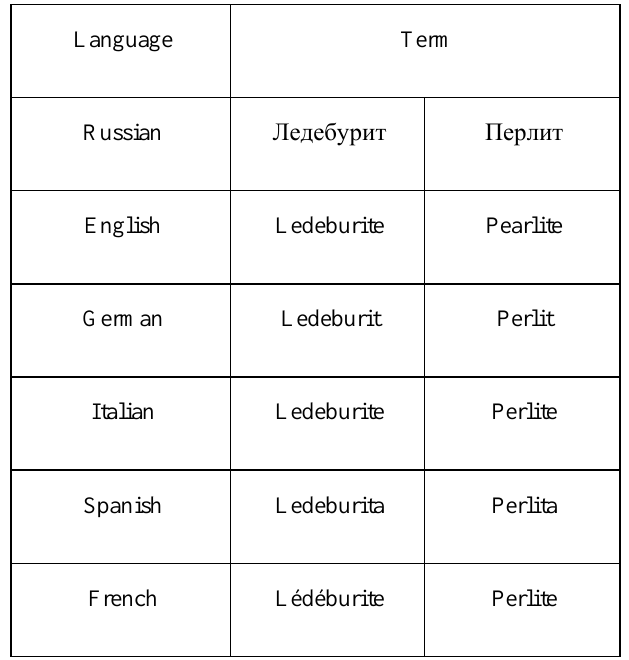
Table 2. Examples of recording terms are ledeburite and perlite in Russian, English, German, Italian, Spanish and